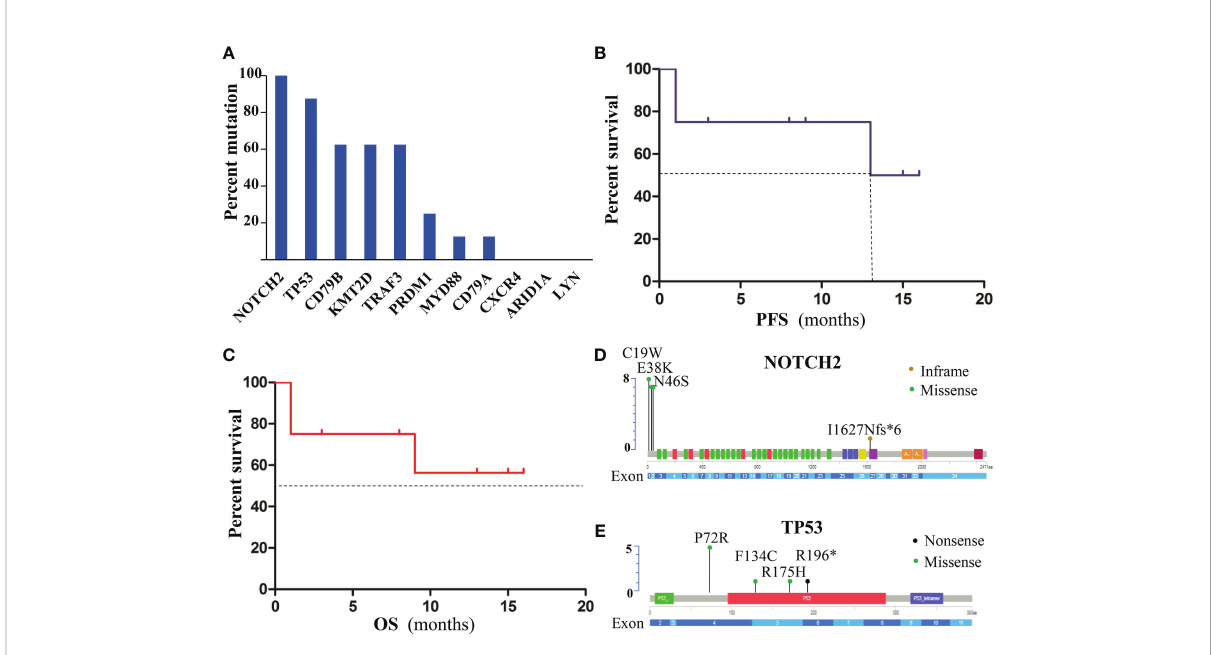
FIGURE 4 Gene mutations of patients with poor response to treatment. (A) Frequency of gene mutations. (B) PFS of patients. (C) OS of patients. (D) mutation location of NOTCH2 at the protein level. (E) TP53 Mutations at the protein